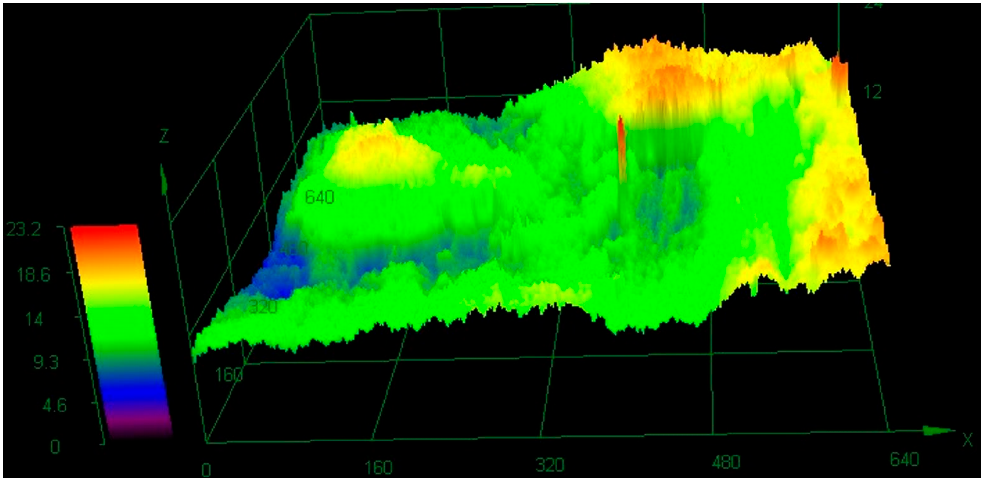
Figure 18. The 3D mapping of the friction surface of the composite tested in a dry environment. Polymers 2020 , 12 , x 16 of 18